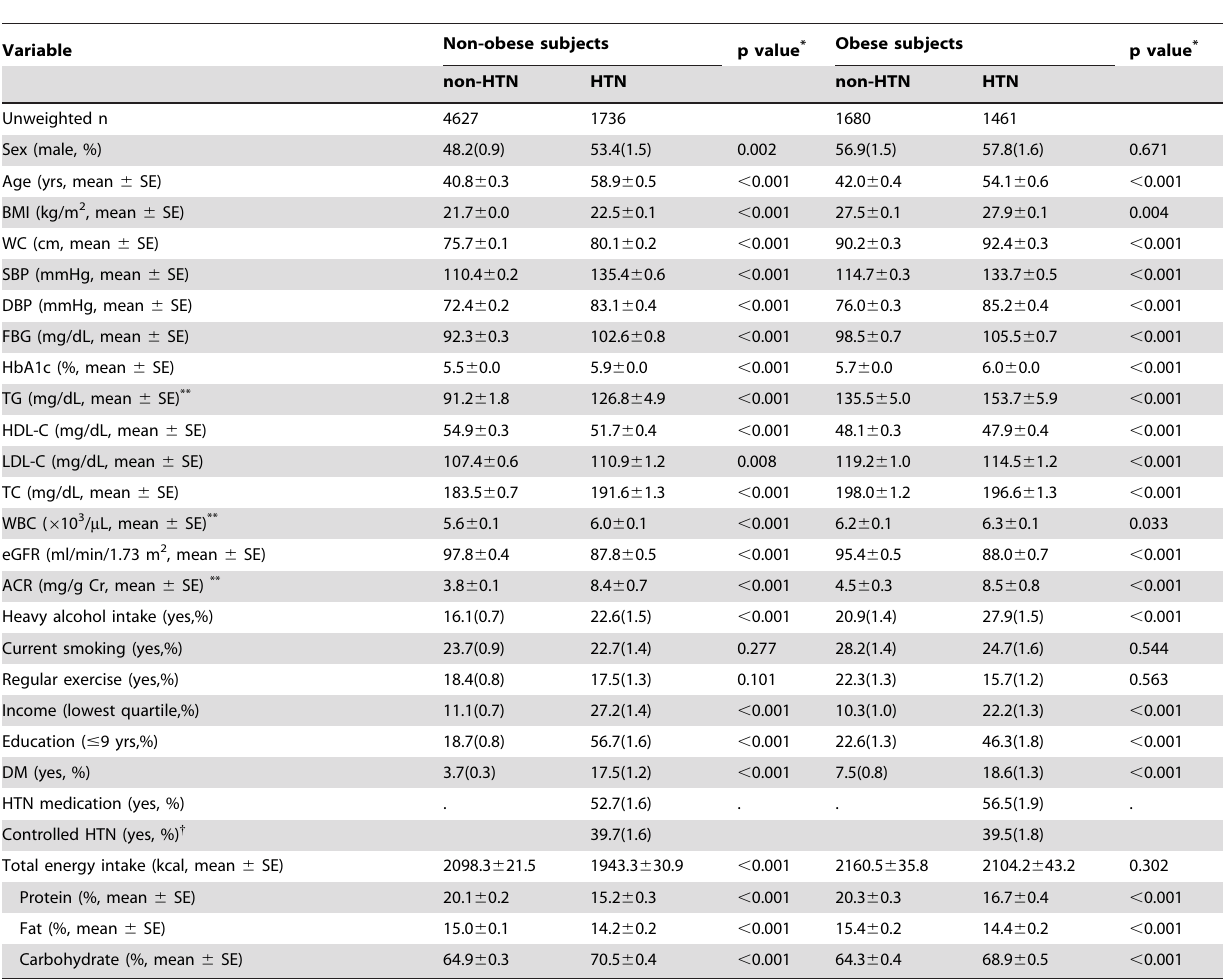
Table 1. General characteristics of subjects with and without obesity and HTN.